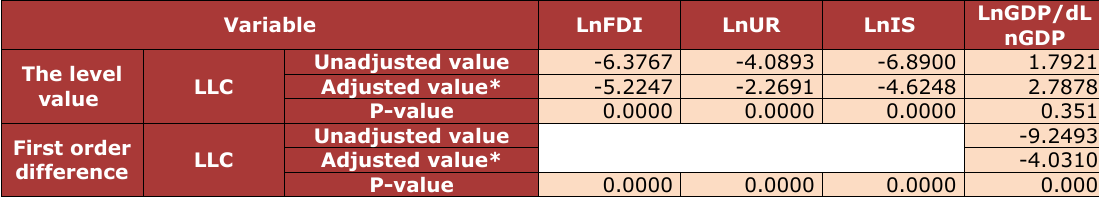
Table 2. Results of panel unit root rest of Jiangsu province